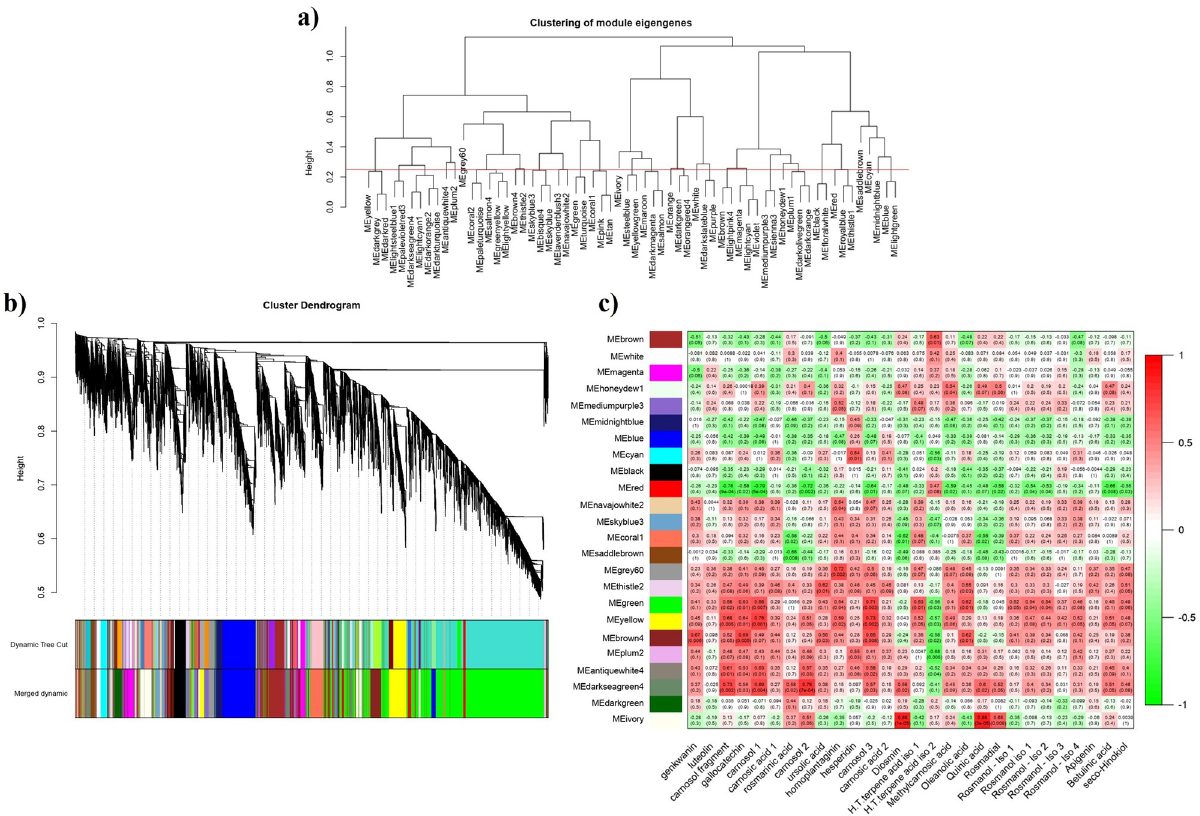
Fig 2. The gene network analysis of the biosynthesis pathway of secondary metabolites in R . officinalis . a) Clustering dendrogram of the modules, whereas the horizontal line showing merge cut height of 0.25. b) Co-expression modules constructed. Dendrograms produced by average linkage of hierarchical clustering of genes, which is based on a topological overlap matrix (TOM). The modules were assigned colors as indicated in the horizontal bar beneath the dendrogram. c) Heat map of correlation between eigengene modules and secondary metabolites. Each row shows a module eigengene, each column shows a secondary metabolite. Each cell contains the corresponding correlation and P-value . The correlation between modules and secondary metabolites in the cells has a ratio ranged from -1 to +1. The more this ratio closer to +1, the color changes from green to red.